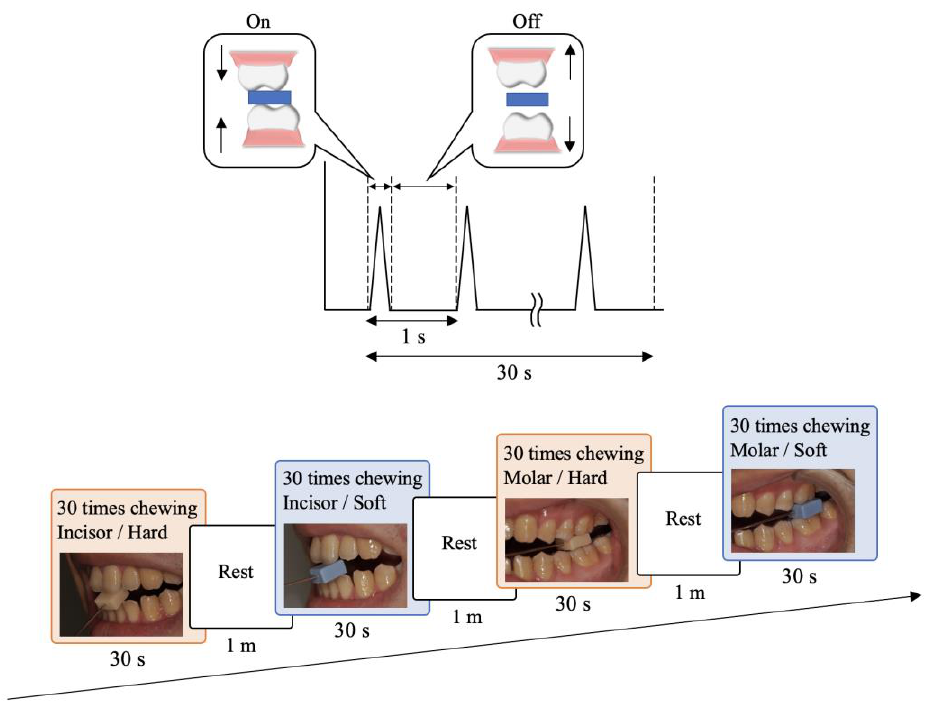
Figure 1. Serial measurement of each condition. The order of experimental tasks was randomized and repeated four times.